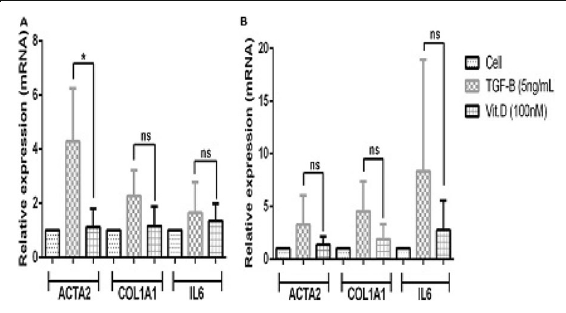
Fig. 1 (abstract O82). Evaluation of 1,25(OH)2D3 treatment on the gene expression of ACTA2, COL1A1, and IL6 in healthy skin (HFF-1) ( a ) and lung (MRC-5) ( b ) fibroblasts. Values of relative quantification after normalization with reference gene 18S through